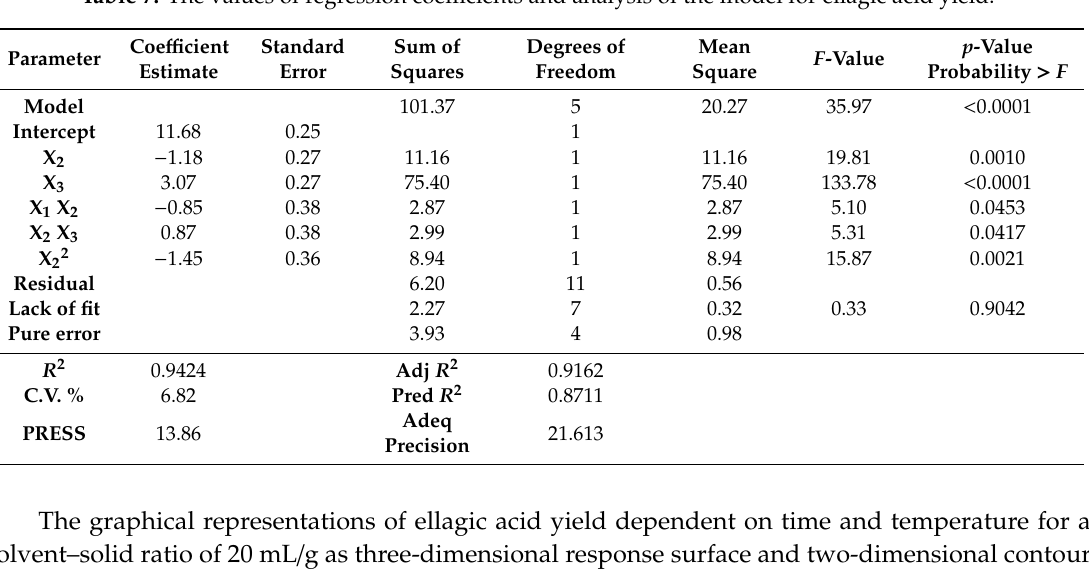
Table 7. The values of regression coe ffi cients and analysis of the model for ellagic acid yield.